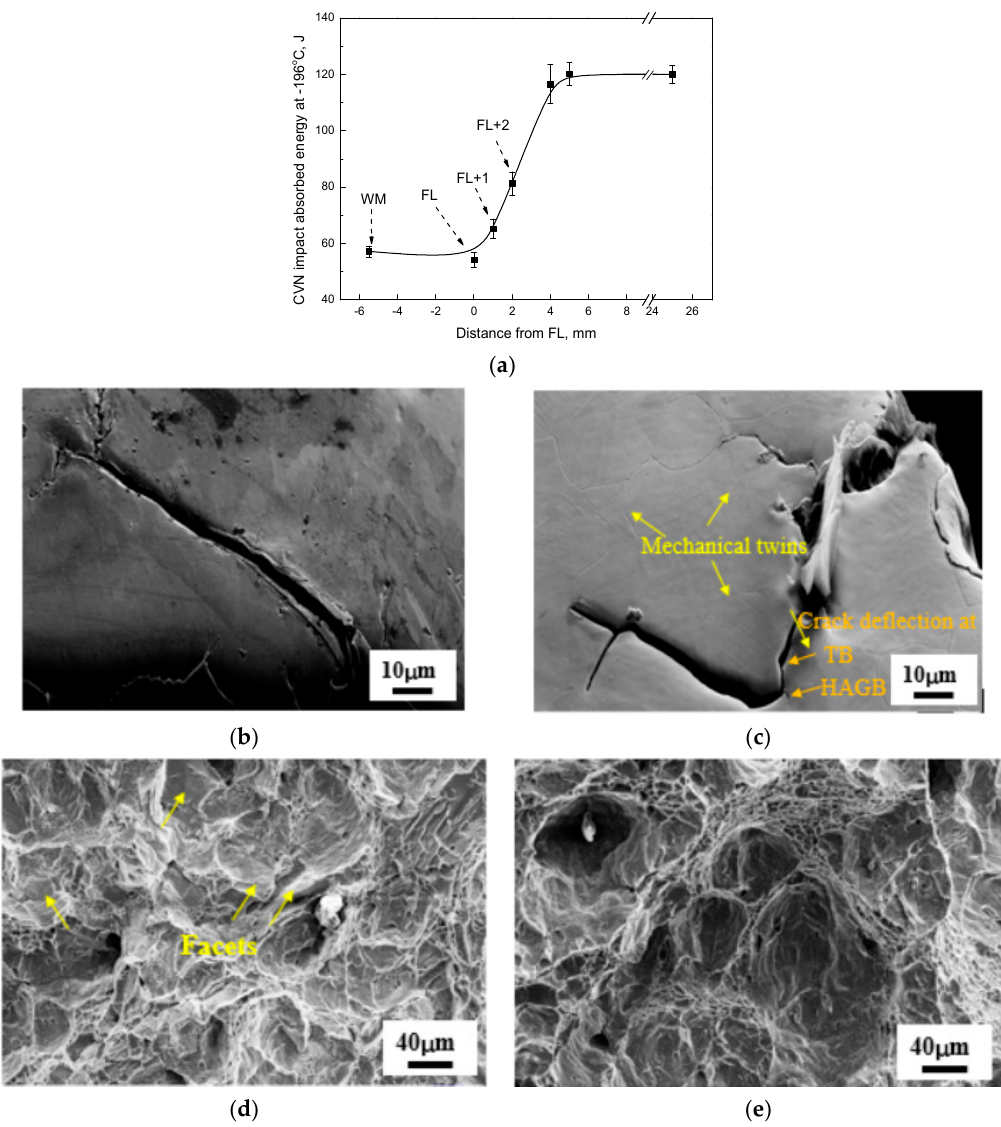
Figure 5. ( a ) Cryogenic Charpy V-notch impact absorbed energy profile across the WJ, secondary cracks underneath fracture surface at the ( b ) FL location, ( c ) BM, and fracture morphology of impact samples at the ( d ) FL location, ( e ) BM. The mechanical twins are indicated by yellow arrows in ( c ) and the crack deflection at TB and HAGB are also indicated by orange arrows in ( c ). The facets in fractograph are also indicated by yellow arrows in ( d